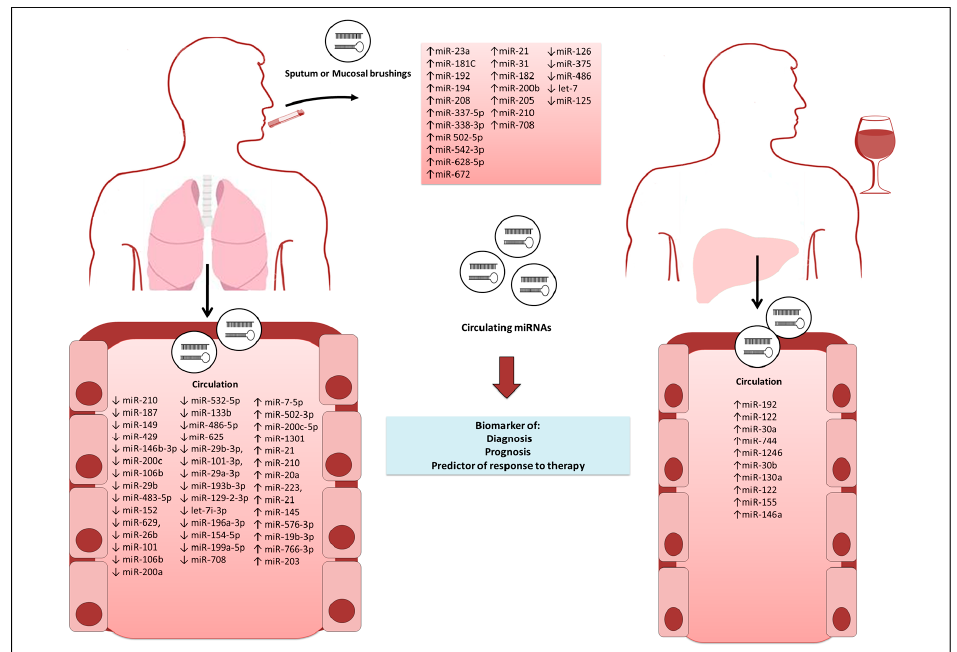
Figure 1. Circulating microRNAs (miRNAs) as early diagnostic biomarkers in tobacco- and alcohol-associated diseases. Circulating miRNAs from blood and sputum or mucosal brushings can be obtained through a minimally invasive technique and have been exploited to assist in the early diagnosis of several diseases.